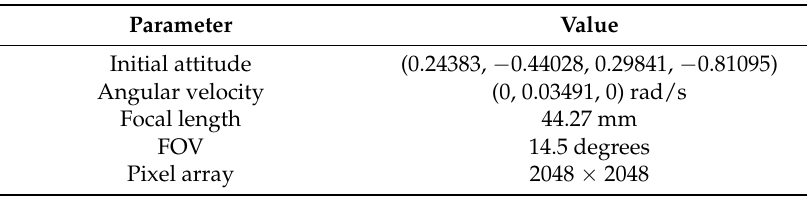
Table 4. Star sensor parameters for the night sky